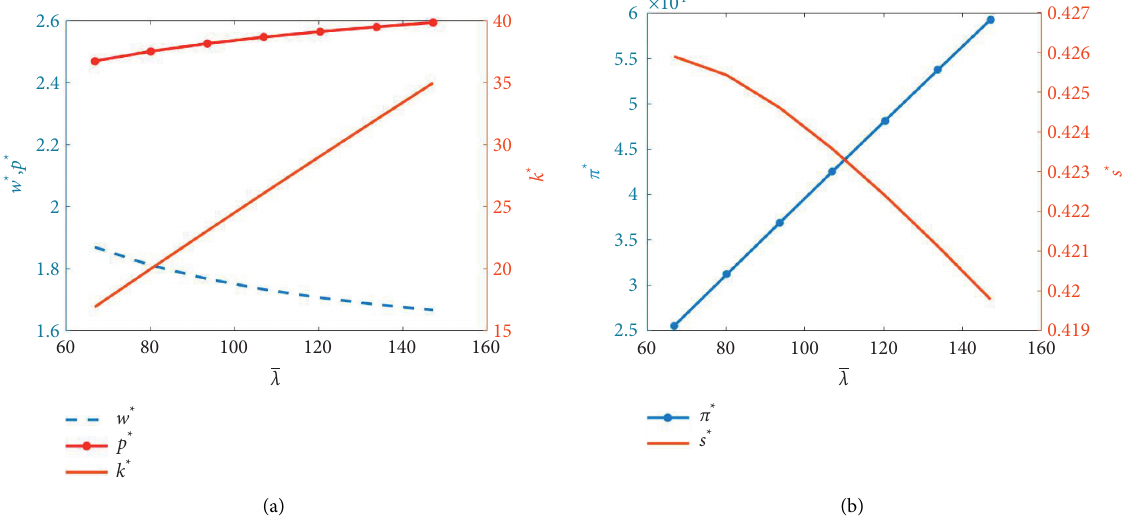
Figure 9: Sensitivity analysis of endogenous variables in terms of λ . (a) p ∗ , w ∗ , and k ∗ . (b) s ∗